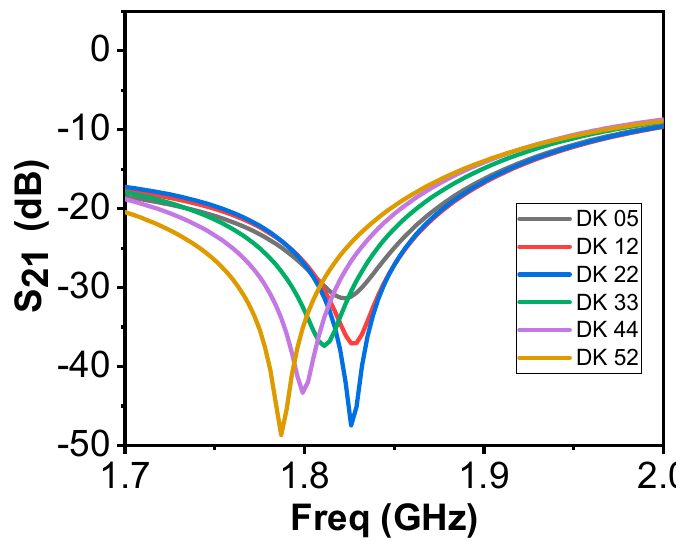
Figure 8. Simulations on one-layer model using the bandstop sensor.